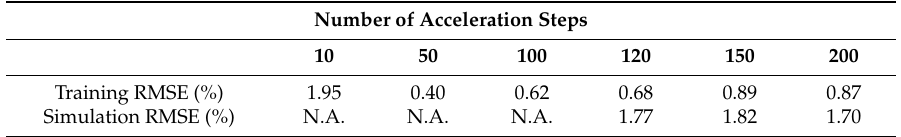
Table 2. Training results considering various acceleration steps for the multilayer perceptron